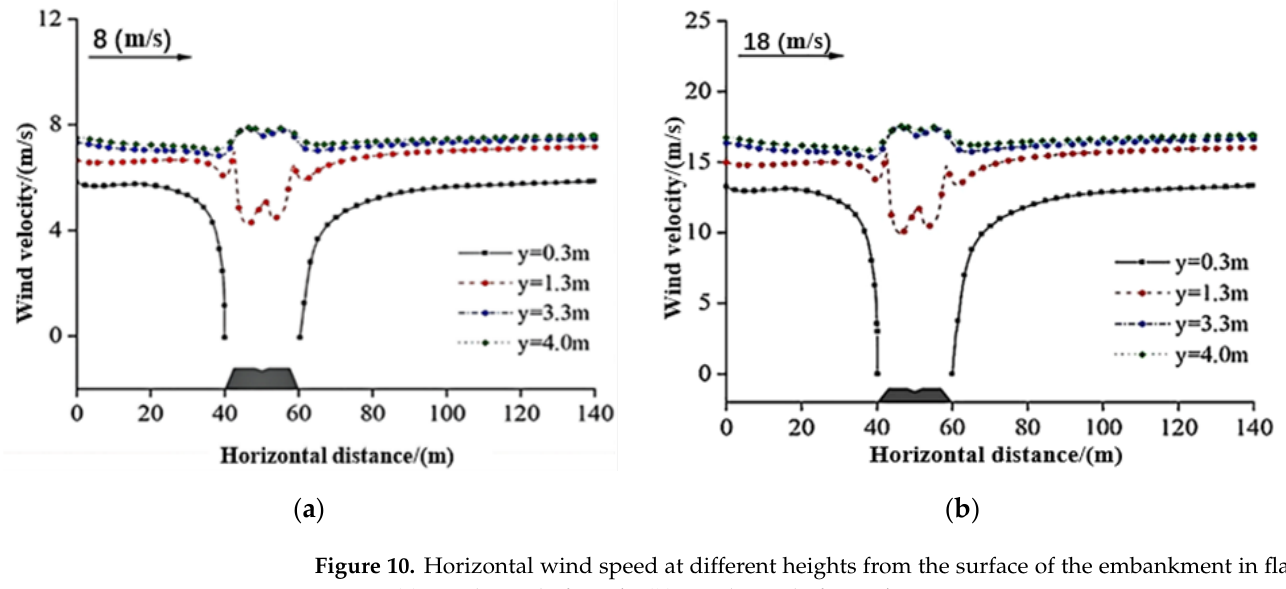
( b ) Figure 9. Distribution of wind-sand flow field around subgrade in flat terrain ( a ) and windward dune ( b ). 3.4. Horizontal Wind Speed Changes at Different Heights The changes of horizontal velocity of airflow on both sides of the embankment at the height of 0.3 m, 1.3 m, 3.3 m, and 3.3 m under different terrain conditions are shown in Figures 10 and 11 where the horizontal wind velocity at the height of 0.3 m and 1.3 m is within the influence range of dune and embankment height, thus the velocity curve is discontinuous. The horizontal wind velocity at the height of 3.3 m and 4 m presents an “M” shape distribution and if there is a dune, the maximum wind speed will concentrate on the top of the dune. When the wind speed is 18 m/s, the greatest reduction in wind speed is observed at the junction between the embankment and the dune where the wind speed at the foot of the leeward slope of the dune is 1.81 m/s at the height of 1.3 m, which is 87.9% lower than the original wind speed, followed by the leeward slope foot of em-